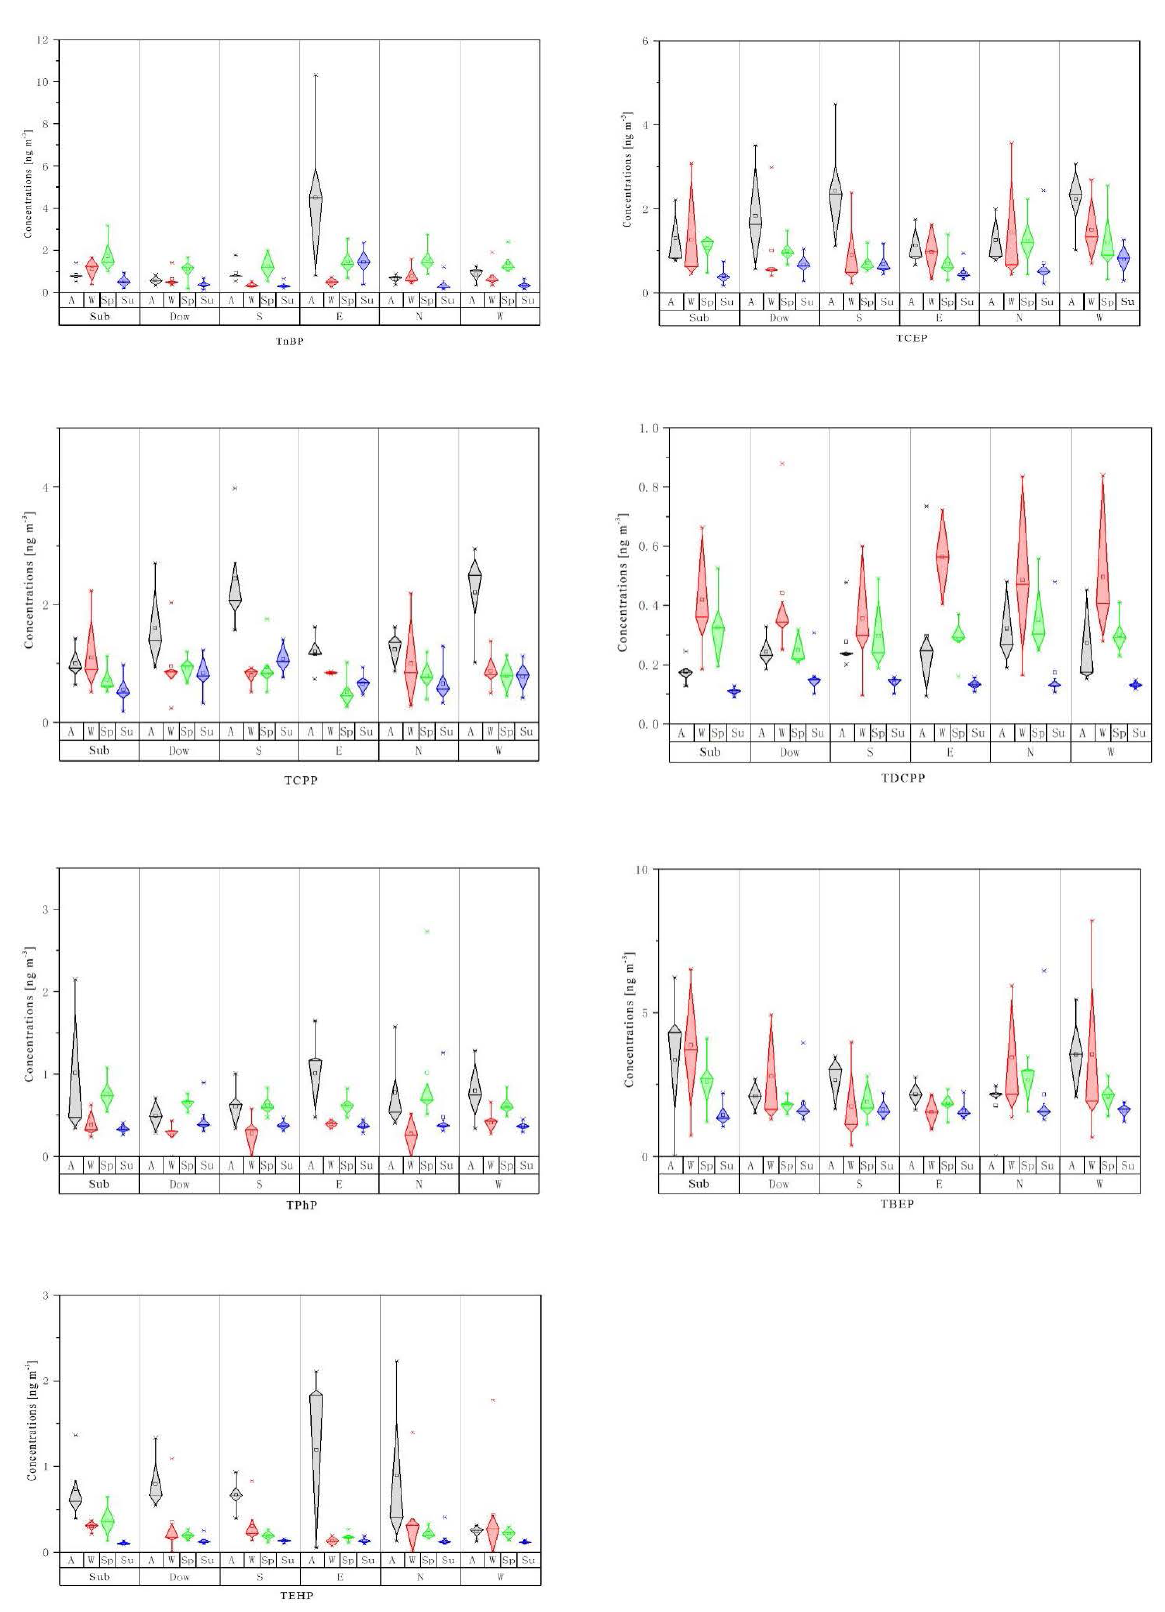
Figure 3. The seasonal variation of individual OPEs in PM 2 . 5 from the city of Chengdu. A: autumn, W: winter, Sp: spring, Su: summer, Sub: suburbs, Dow: downtown, S: south, E: east, N: north, W: